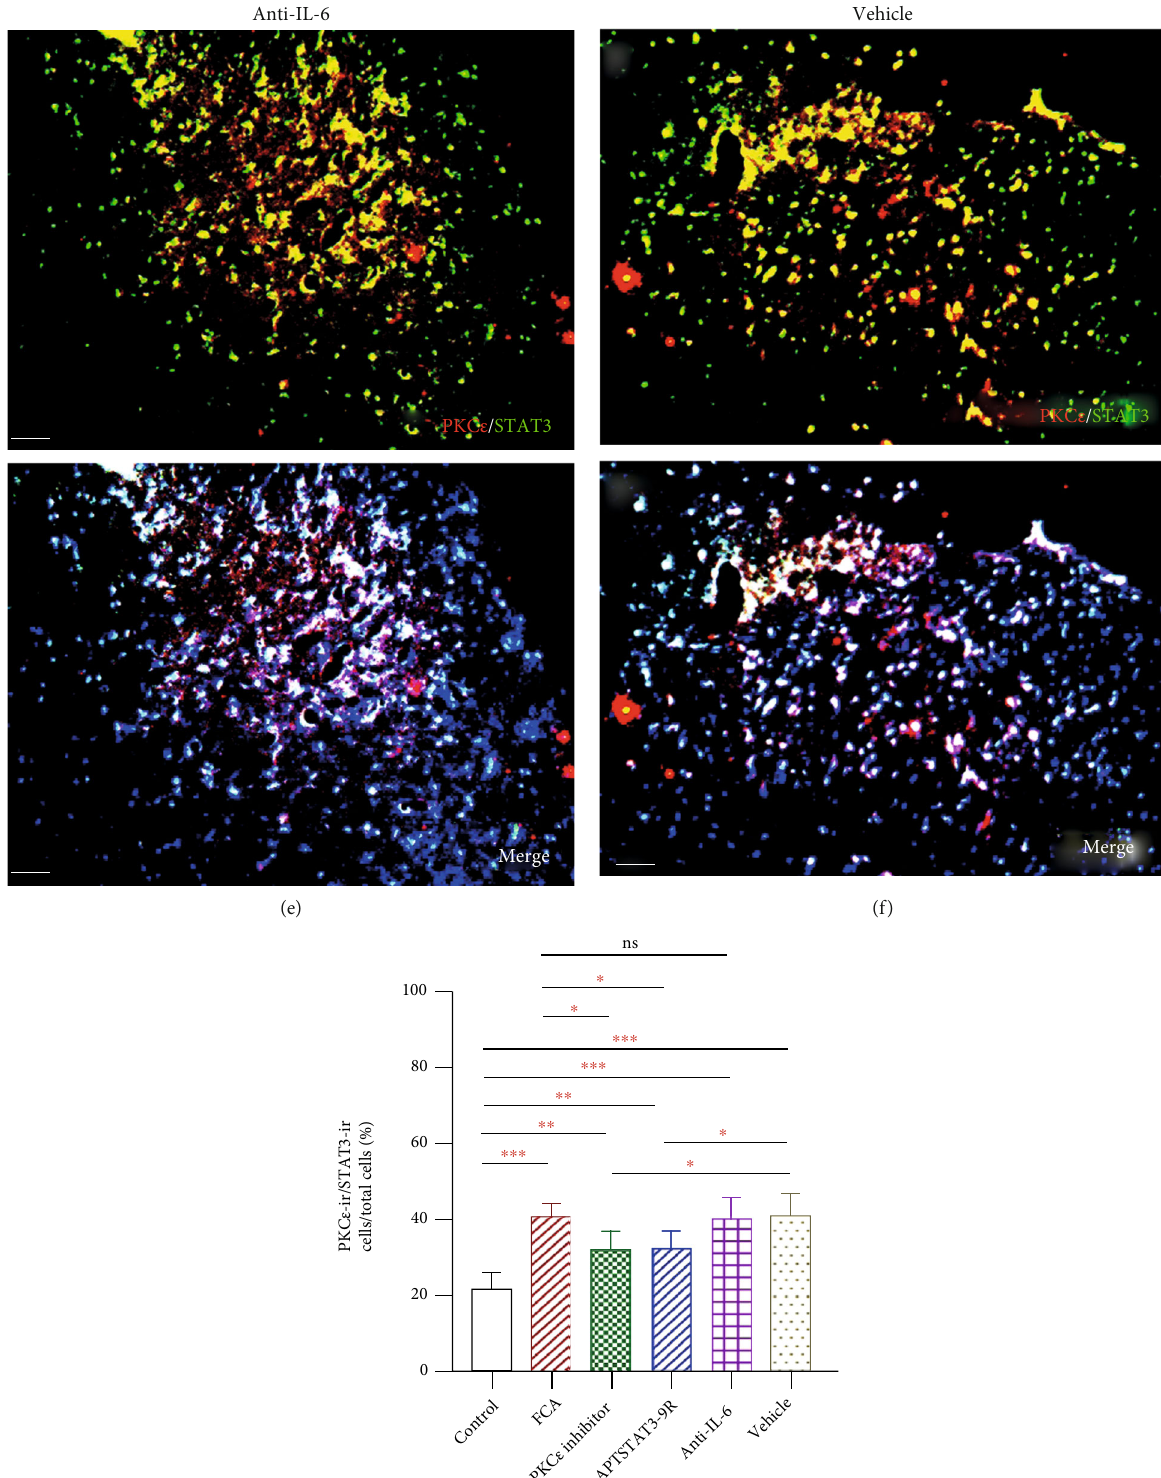
Figure 6: Detection of PKC ε and STAT3 coexpression in vivo and their immune complexes in vitro . (a – f) Immuno fl uorescence staining for PKC ε (red) and STAT3 (green) coexpression (yellow) and DAPI (blue in merged image) in spinal cord sections (a – e). Ratios of cells with immunoreactive PKC ε -/STAT3 among total cells. (f) Inhibitors of PKC ε and STAT3 signi fi cantly decreased the coexpression of PKC ε / STAT3 after APTSTAT3-9R administration. Bar = 40 μ m. Data are shown as means ± SD ( n = 6 ). ∗ P < 0 : 05 , ∗∗ P < 0 : 01 , ∗∗∗ P < 0 : 001 ; one-way ANOVA followed by Bonferroni